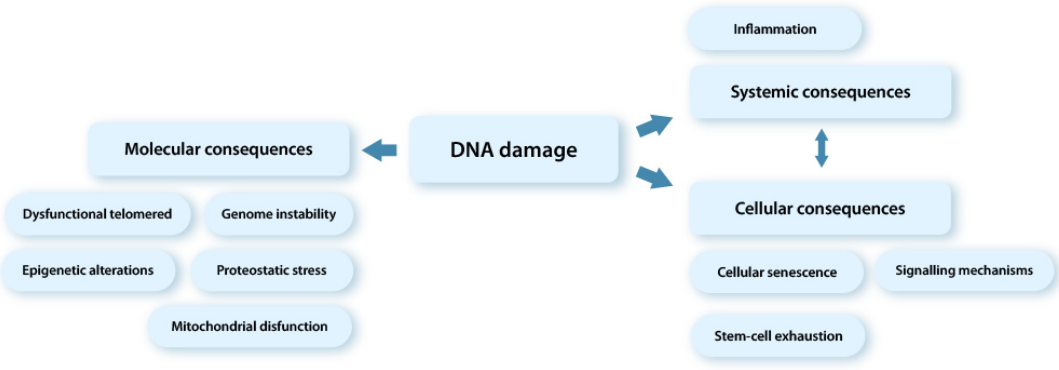
Figure 2. Consequences of DNA damage at the molecular, cellular, and tissue levels.